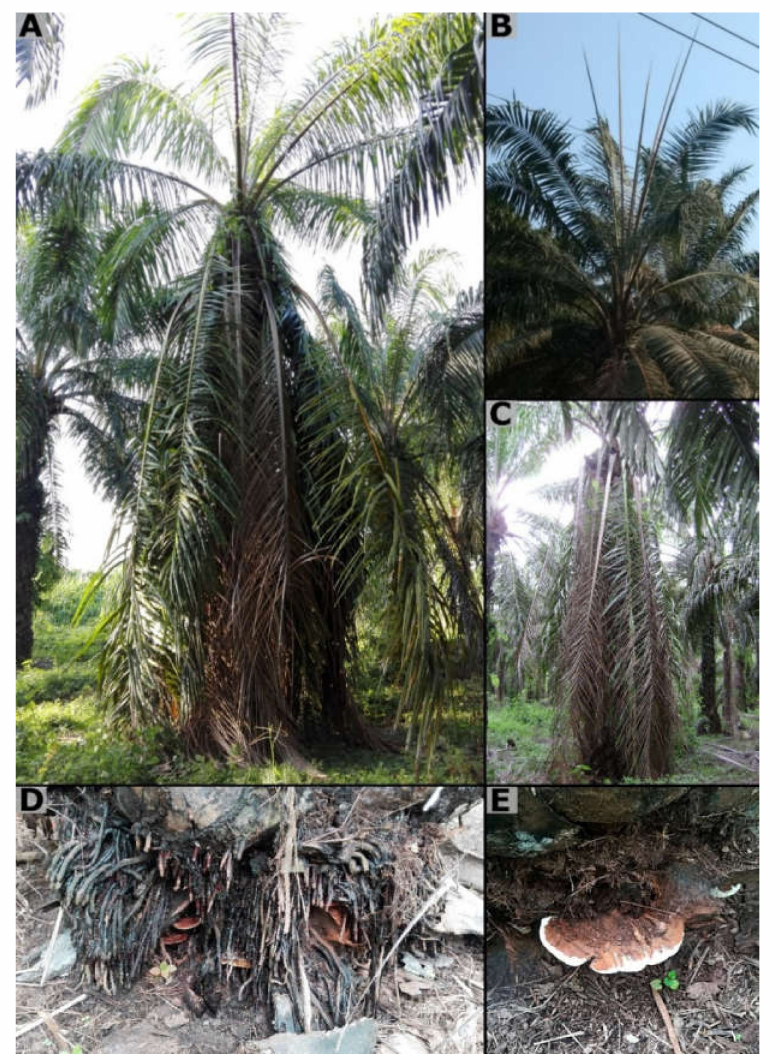
Figure 1. External symptoms observed in oil palms affected by BSR in the field in Colombia. ( A ) Oil palm with symptoms of wilting and chlorosis. ( B ) Unopened spears. ( C ) Snapping/flattening of the crown. ( D ) Formation of adventitious roots. ( E ) Typical basidiocarps of Ganoderma zonatum on a BSR affected